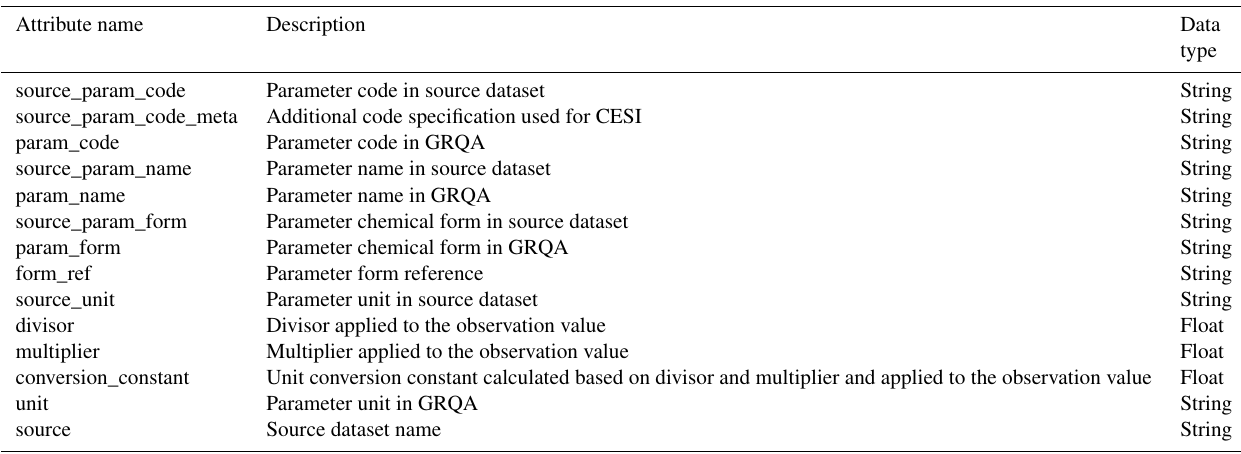
Table 3. Summary table of lookup table attributes.